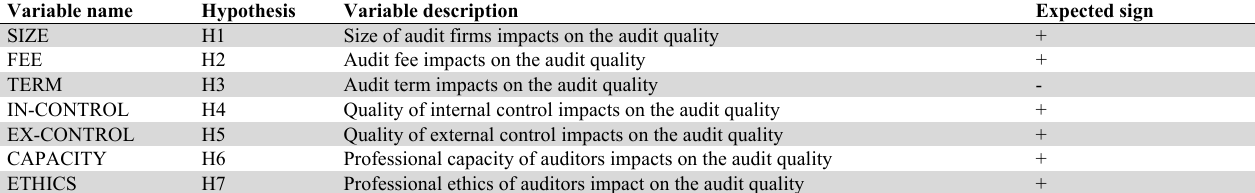
Summary of research hypotheses of independent variables to Auditing quality